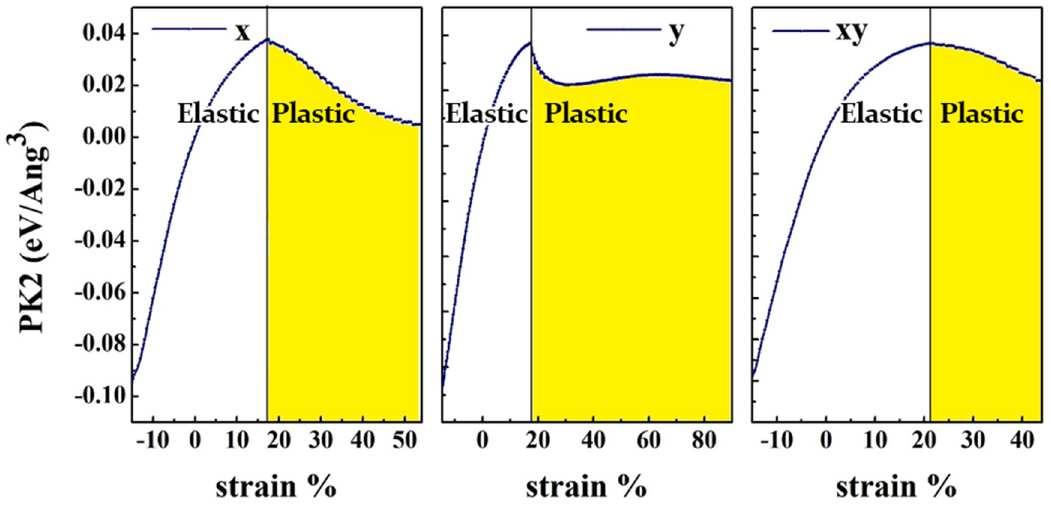
Figure 4. Σ m and η m denote the x , y , and x - y components of the stress and strain, respectively. The line separates the harmonic and anharmonic regions. The yellow area shows the plastic region. Table 2. Ultimate strains ( η m ) and ultimate stresses ( Σ m ) for three (D 1 , D 2 , and D 3 ) types of strains.